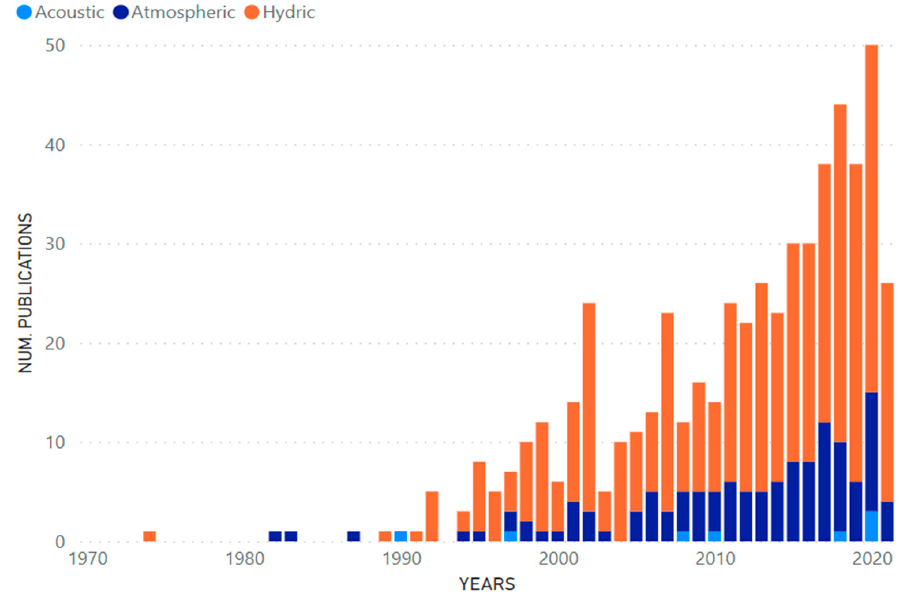
Figure 7. Contribution of scientific publications by years.